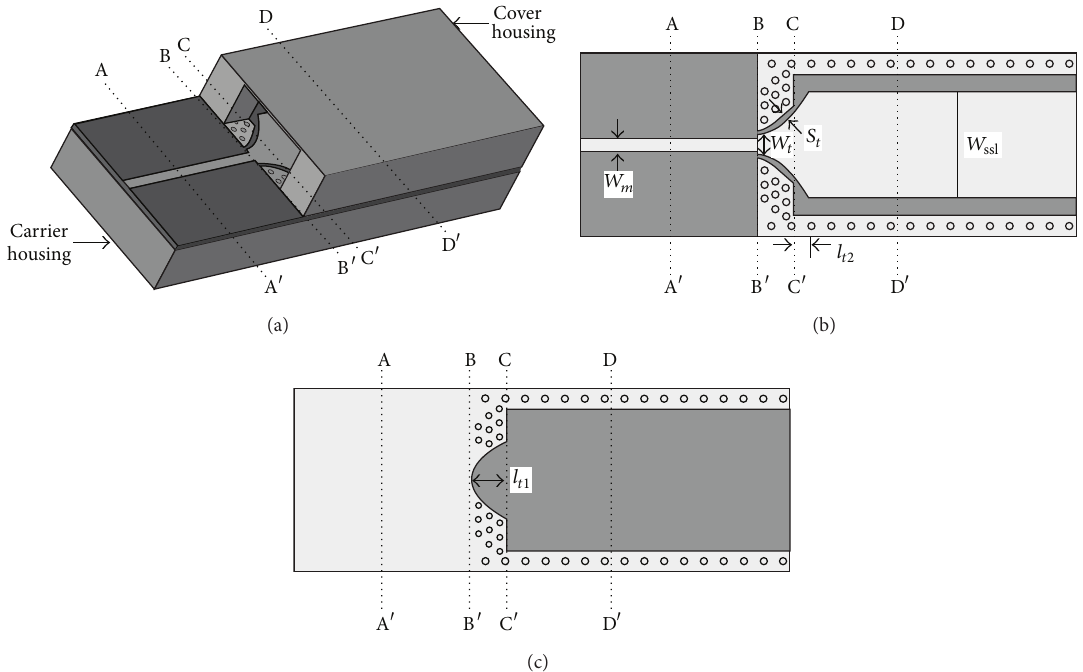
Figure 2: Proposed configuration of the MSL-to-SSL transition: (a) perspective view, (b) top view, and (c) bottom view.